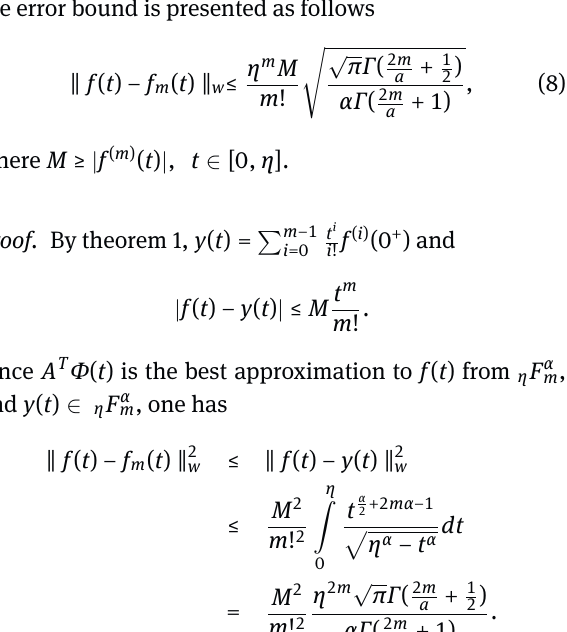
Fig. 1: Graphs of the GFCFs for various values of n and α